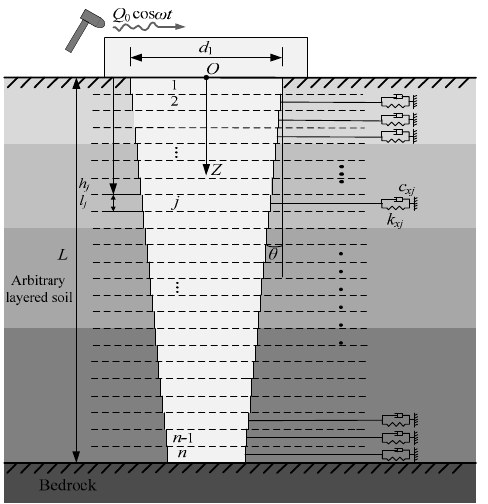
Figure 1. Transverse coupling vibration model of TP.